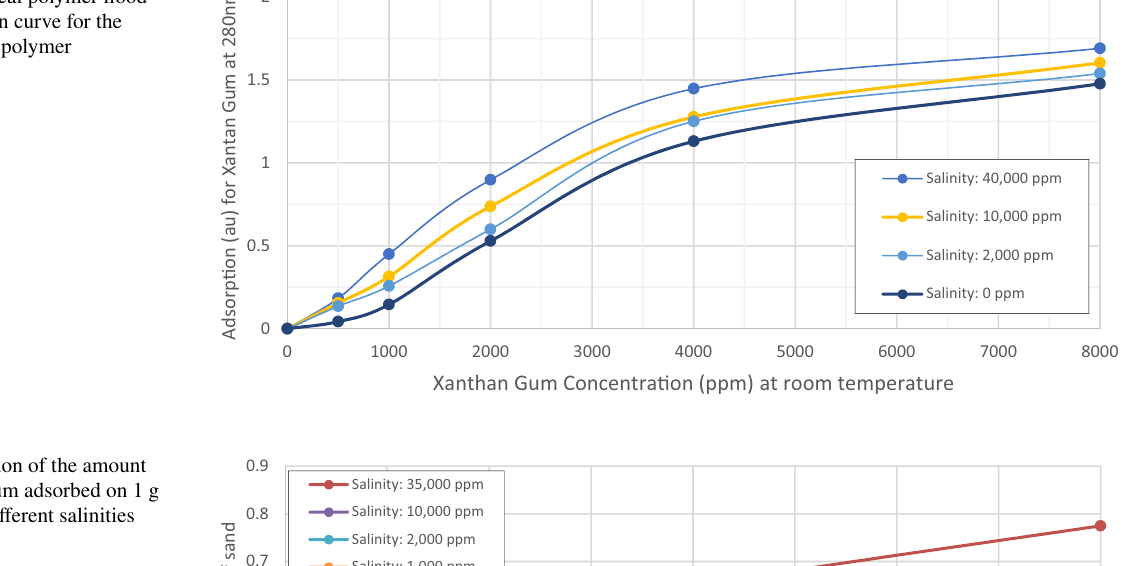
Fig. 3 A typical polymer flood- ing calibration curve for the xanthan gum polymer